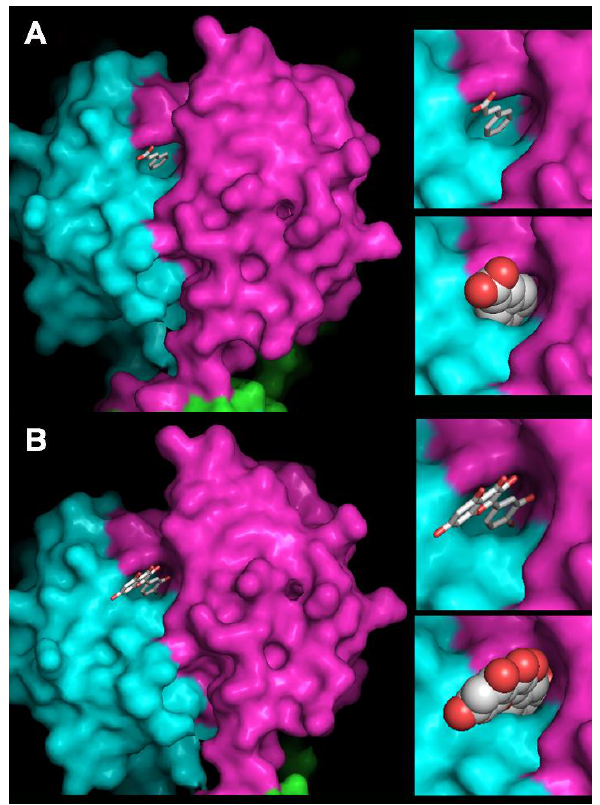
Figure 6. Homology model of phage OE33PA RBP with inhibitors docking. Docking of cinnamic acid ( A ) and quercetin ( B ) in the RBP binding cavity. The trimeric RBP surface is colored pink, blue and green. The binding cavity is at the interface between the pink and blue domains. Cinnamic acid and quercetin are displayed as balls and sticks in the main frame and in the upper close-up and as atomic spheres in the lower close-up. Carbons are colored white and oxygens red. Hydrogens are not displayed. Pictures made with PyMOL (The PyMOL Molecular Graphics System, Version 2.0